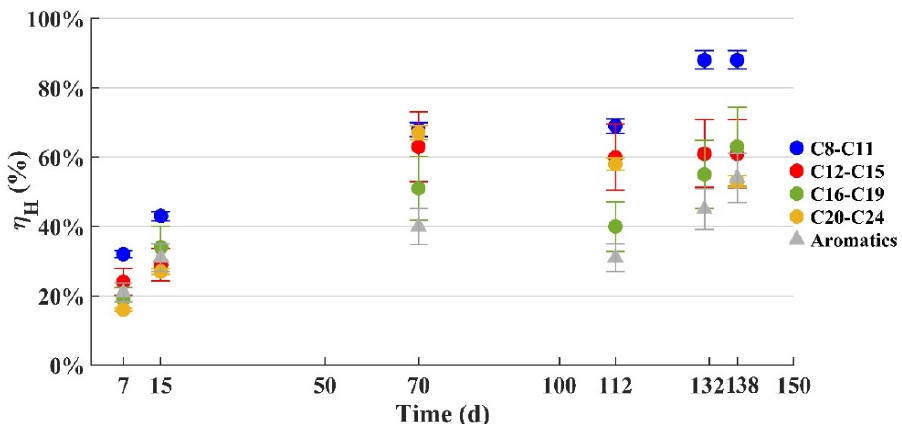
Figure 4. Removal efficiency of hydrocarbon clusters. Relative standard deviation range: 1.91–12.91%.